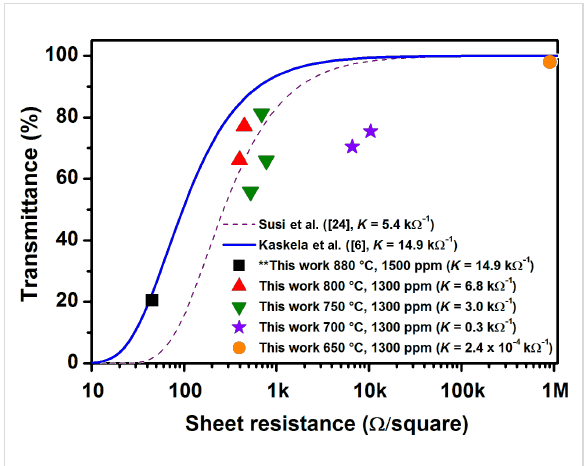
Figure 6: Comparison of sheet resistance versus optical transparency (at 550 nm) of SWCNTs synthesized at different temperatures (650–880 °C). The black square represents the benchmark sample (880 °C), red upright triangles SWCNTs from 800 °C, green downright triangles SWCNTs from 750 °C, purple stars SWCNTs from 700 °C and the orange circle SWCNTs from 650 °C. The blue solid line and the purple dashed line represent the literature data used for compar-